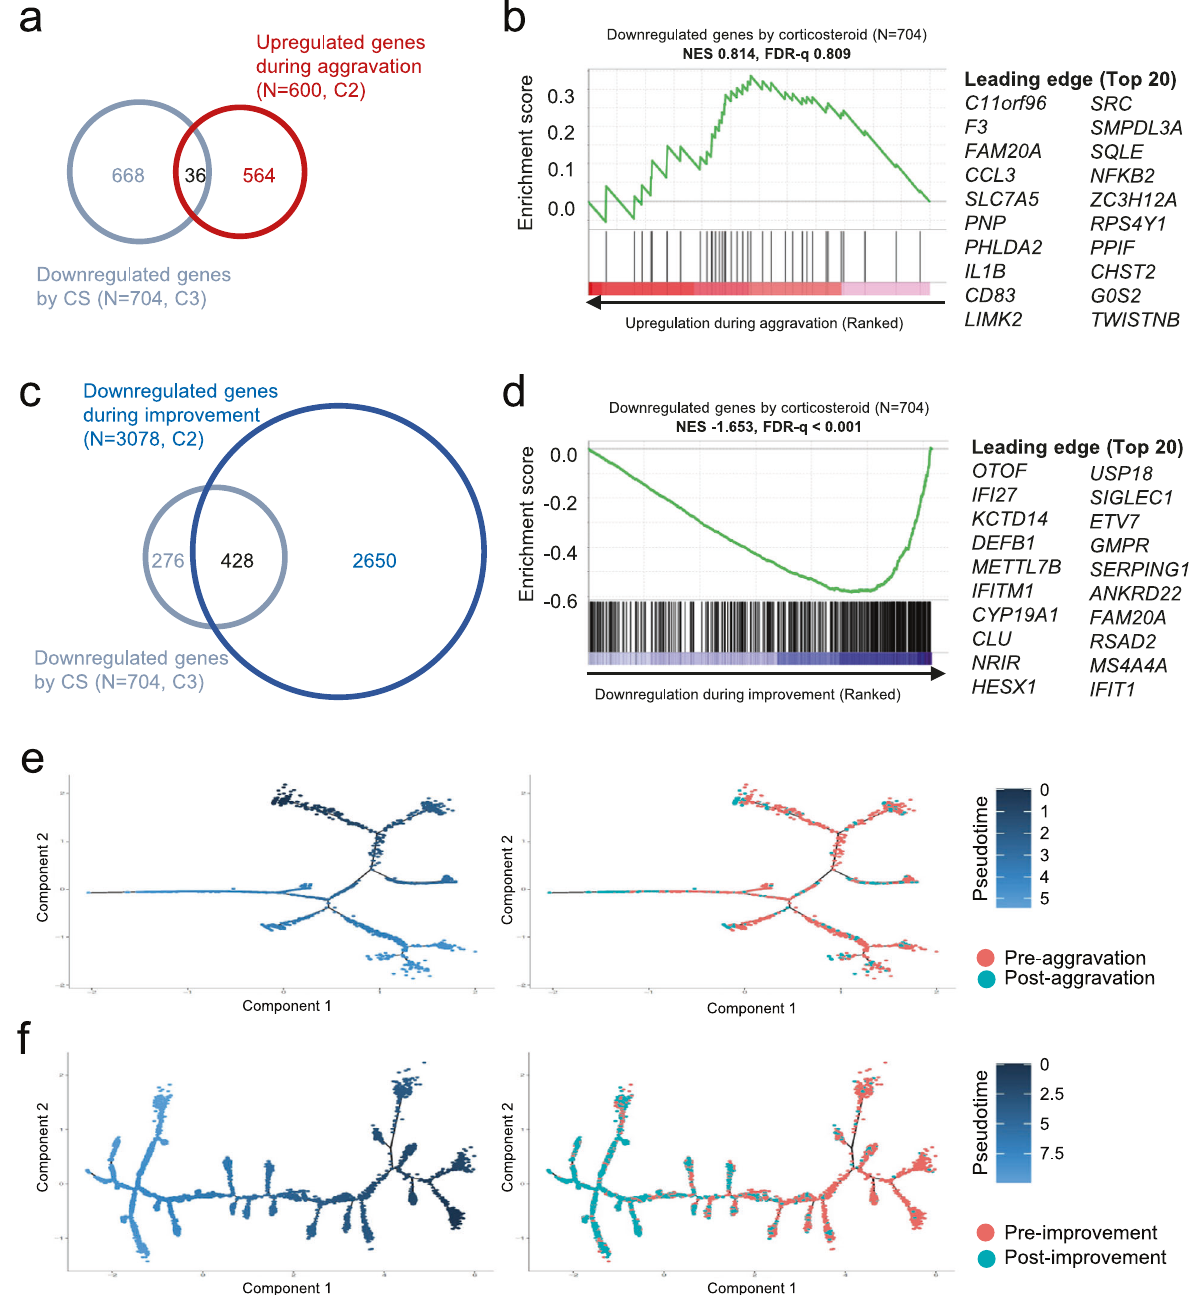
Fig. 6 Similarities between genes downregulated by corticosteroid (CS) treatment and genes with altered expression during the course of COVID-19 in classical monocytes (CMs) and intermediate monocytes (IMs). a Venn diagram showing the overlap of genes downregulated by CS treatment ( n = 704, C3) and genes upregulated during aggravation of COVID-19 ( n = 600, C2). b Gene set enrichment analysis of genes upregulated during aggravation of COVID-19 ( n = 600, C2 in a ) for gene sets downregulated by CS treatment. FDR, false discovery rate; NES, normalized enrichment score. c Venn diagram showing the overlap of genes downregulated by CS treatment ( n = 704, C3) and genes downregulated during improvement of COVID-19 ( n = 3078, C2). d Gene set enrichment analysis of genes downregulated during the improvement of COVID-19 ( n = 3078, C2 in c ) for gene sets downregulated by CS treatment. e , f Trajectory plots for CMs/IMs in samples from cohort 2 during disease aggravation ( e ) or improvement ( f ). The cells were ordered by the expression of u-ISGs. Colors represent pseudotime (left) or samples